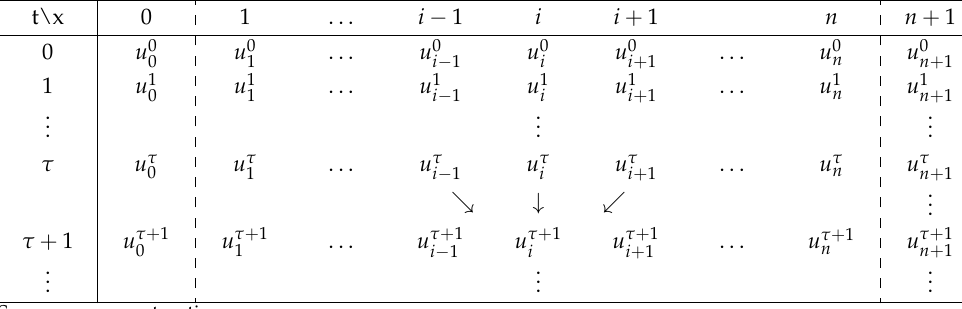
Table 8. Space discretization applied in the one-dimensional heat equation.